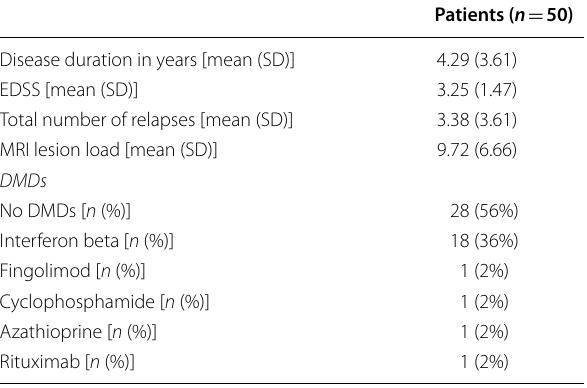
Table 2 Neurological and radiological characteristics of MS patients